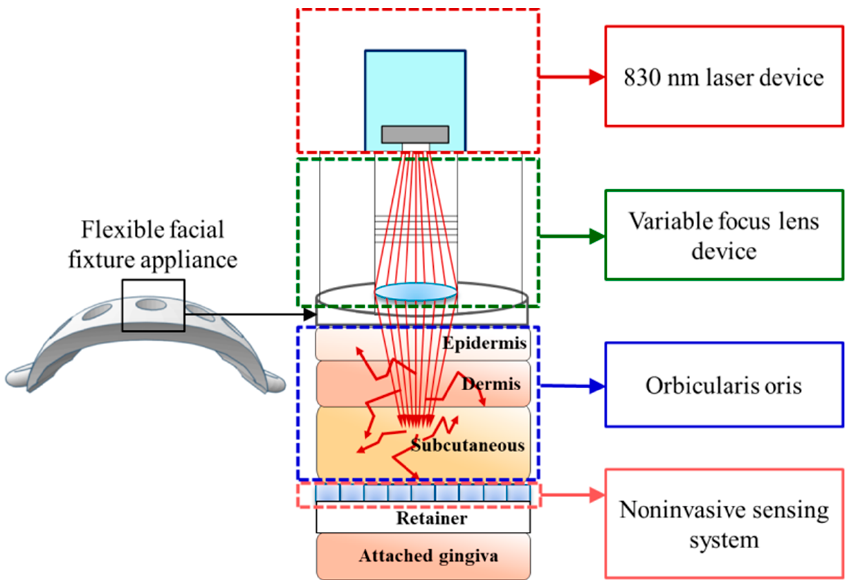
Figure 1. Schematic of the 830 nm laser radiated on the orbicularis oris by noninvasive sensing system. The optical characteristics of backscattering on skin by 660 nm and 825 nm lasers were simulated. The Fresnel reflection coefficients [28,29] and Snell’s law were applied for the optical properties simulation. The skin model of reflection parts was mentioned [30]. The incident power of the 660 nm and 825 nm lasers were set as 30 mW for the simulation. The epidermis layer (refractive index n = 1.34), dermis layer ( n = 1.4), and subcutaneous